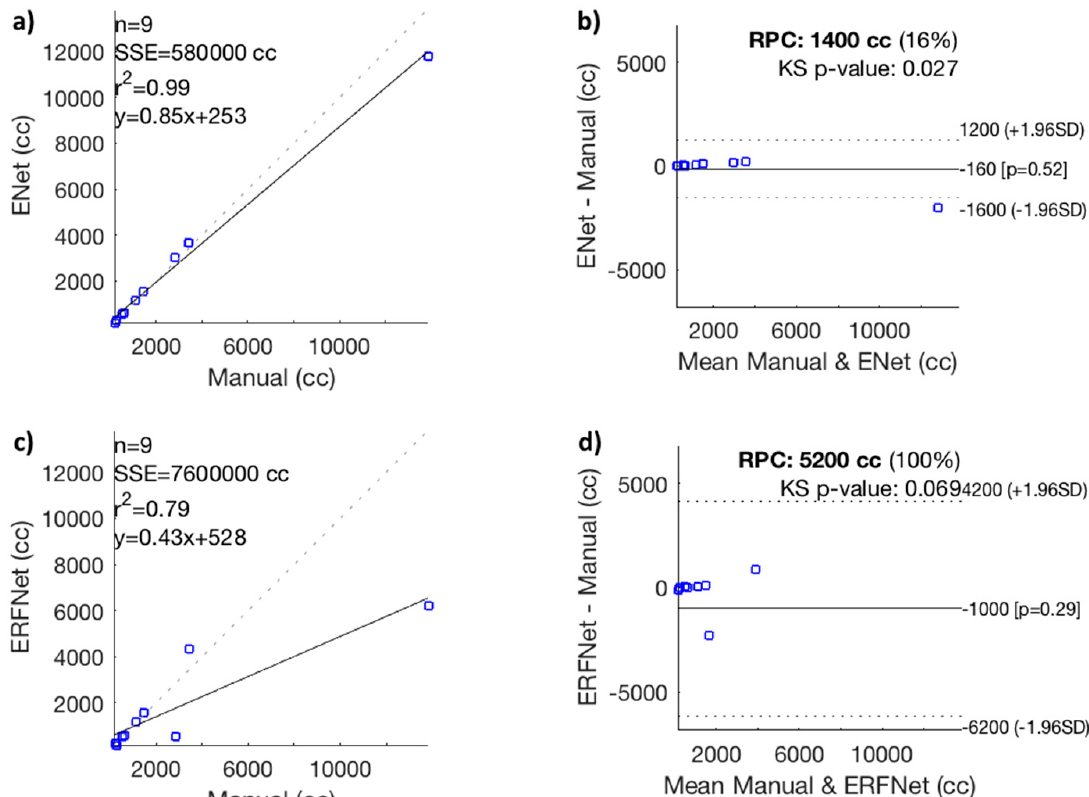
Figure 1. ( a ) Correlation graph, ( b ) Bland–Altman plot between manual and Efficient Neural Network (ENet) volumetric segmentation, ( c ) correlation graph, and ( d ) Bland–Altman plot between manual and Efficient Residual Factorized ConvNet (ERFNet) segmentation. RPC, reproducibility coefficient; SSE, sum of squared error; n, number of data points; p -value, Pearson correlation p -value; r 2 , Pearson r-value squared; cc, cubic centimeters; KS, Kolmogorov–Smirnov test; SD, standard deviation.